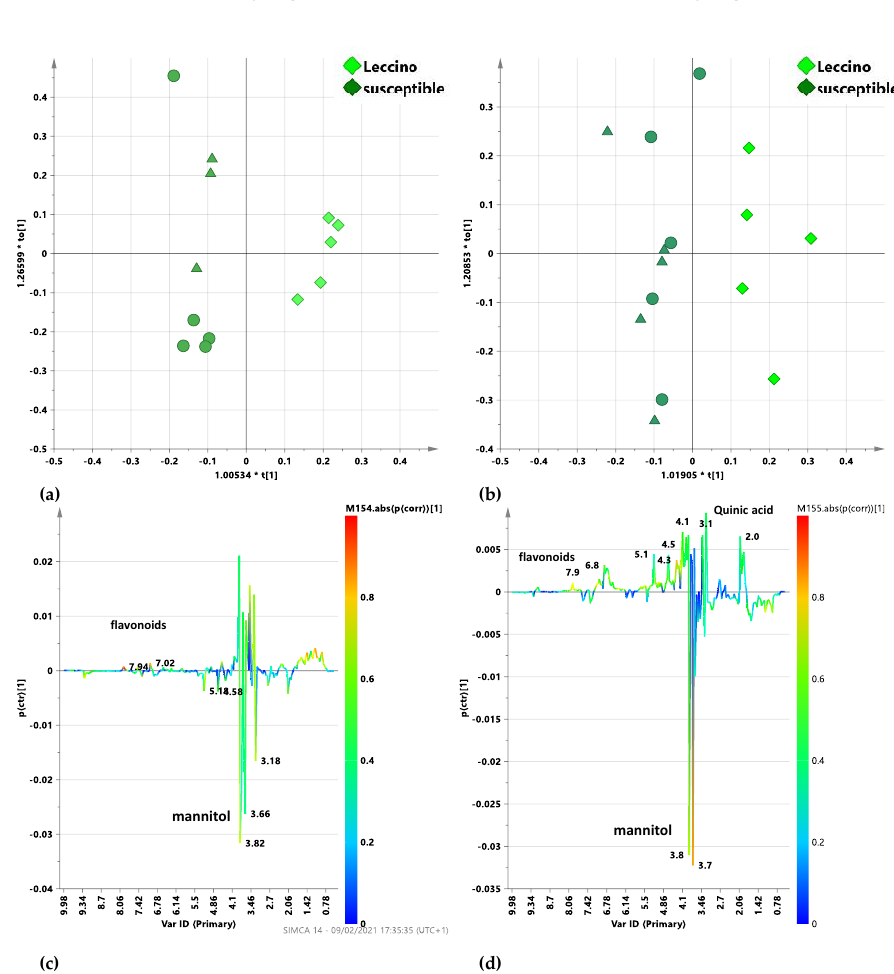
Figure 8. OPLS-DA t[1]/t[2] scores plot for infected Dentamet ® -treated Leccino and susceptible cultivar leaf samples, considering the first ( a ) and the second ( b ) sampling. Different symbol styles for Cellina di Nardò (circles) and Ogliarola salentina (triangles) susceptible cultivars are reported. S-line plots for the, infected Dentamet ® -treated considering the first ( c ) and the second ( d ) sampling related models visualizes the p(ctr)[1] loading colored according to the absolute value of the correlation loading, p(corr)[1].